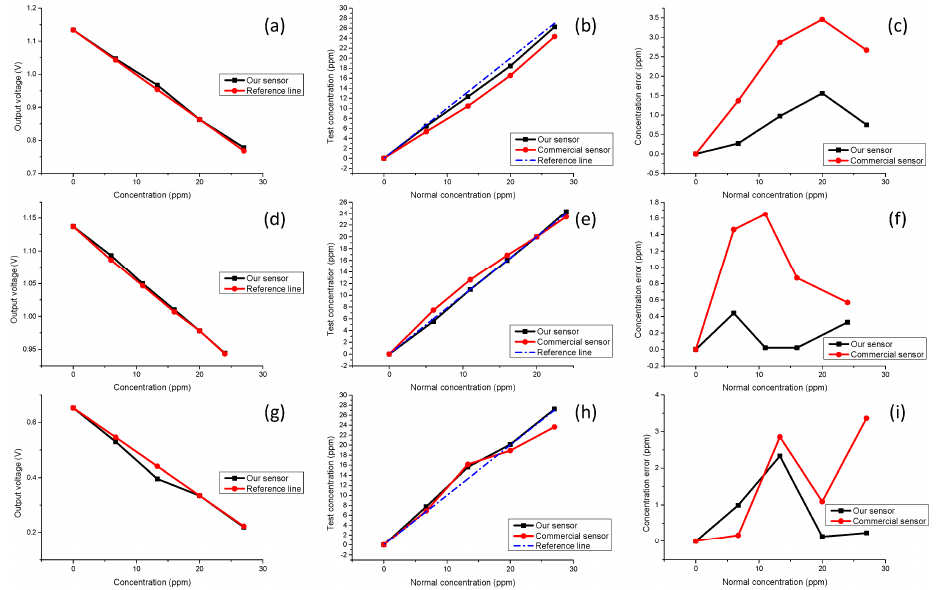
Figure 7. Experimental results. Panel ( a ) shows the output voltage for different concentrations of nitrogen. The back line represents test data and the red line is the reference line; Panel ( b ) shows comparison results. The blue line is the reference line which represents the normal concentration, the red line is the commercial sensor data and the black line represents our sensor; Panel ( c ) shows the detection error for different concentration of nitrogen. The red line is commercial equipment and the black line is our sensor; phosphorus and potassium test results are shown in ( d – f ) and ( g – i ), respectively.